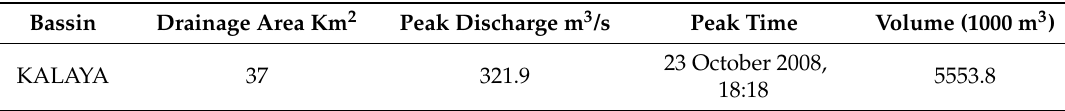
Table 3. Simulation summary results for the KALAYA watershed.